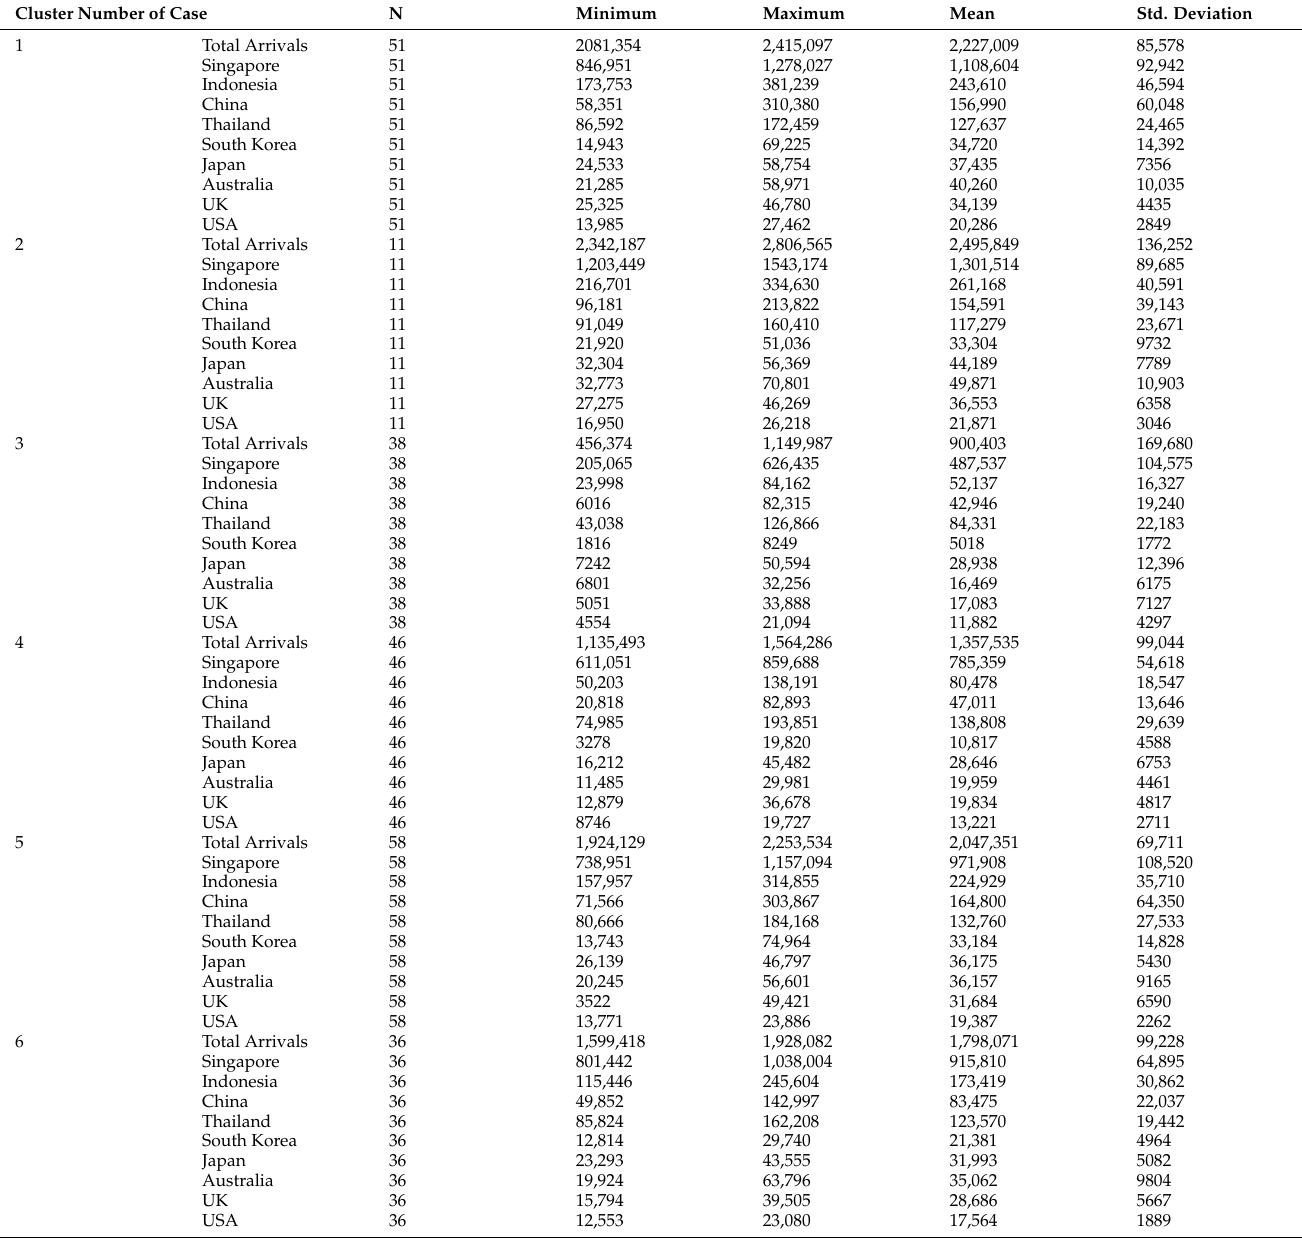
Table 1. Clusters descriptive statistics of tourist arrivals into